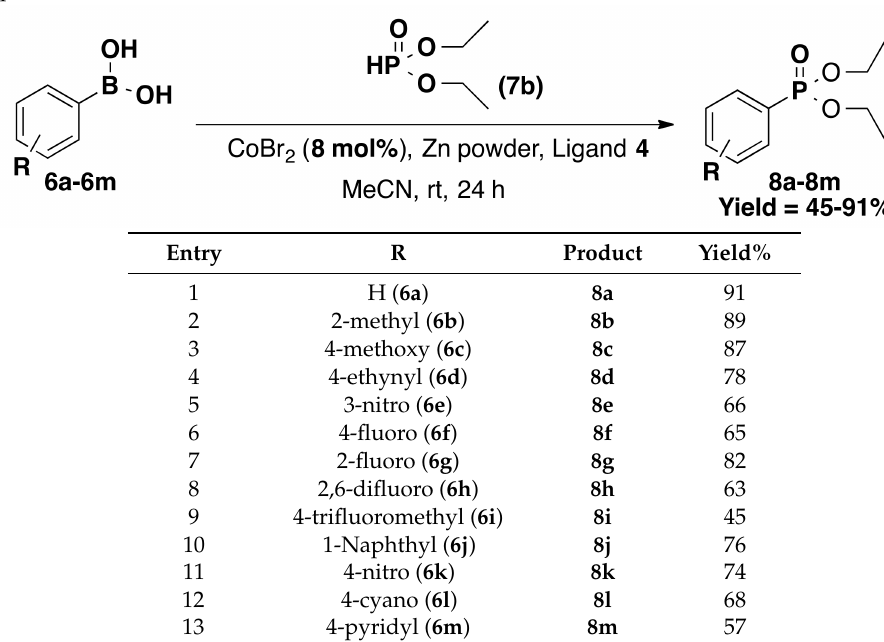
Table 3. Substrate scope for the cross-coupling reaction between boronic acids ( 6a–6j ) and diethyl phosphite ( 7b ) a